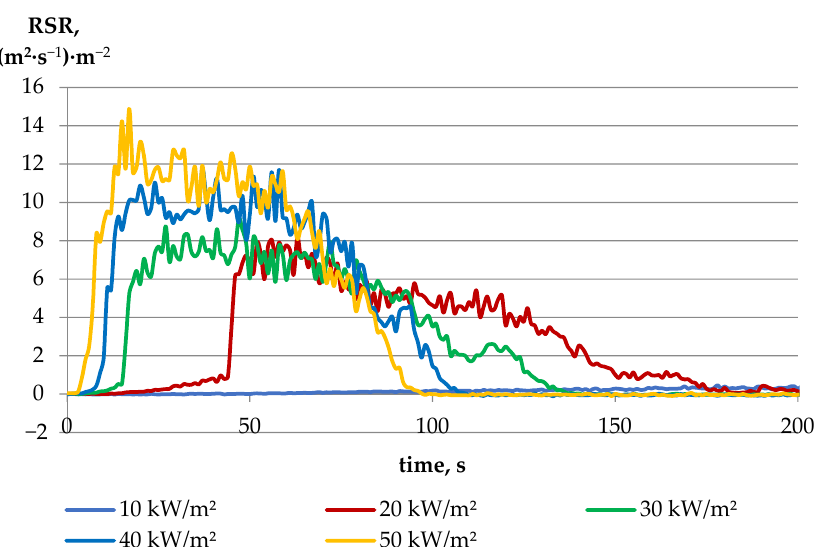
Figure 10. Rate of smoke release (RSR) as a function time for PVC coaxial power cable tested in cone calorimeter.